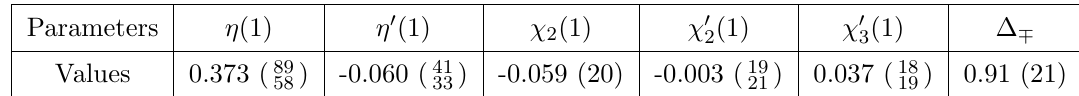
Table 5. The (cid:12)t results for the sub-leading Isgur-Wise functions and (cid:1) (cid:7) .